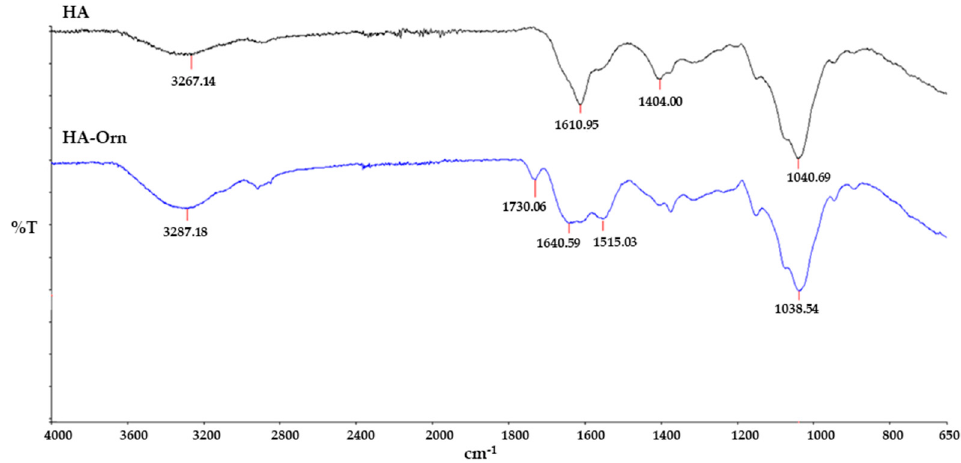
Figure 3. FTIR spectra of native HA and cross-linked HA–Orn.